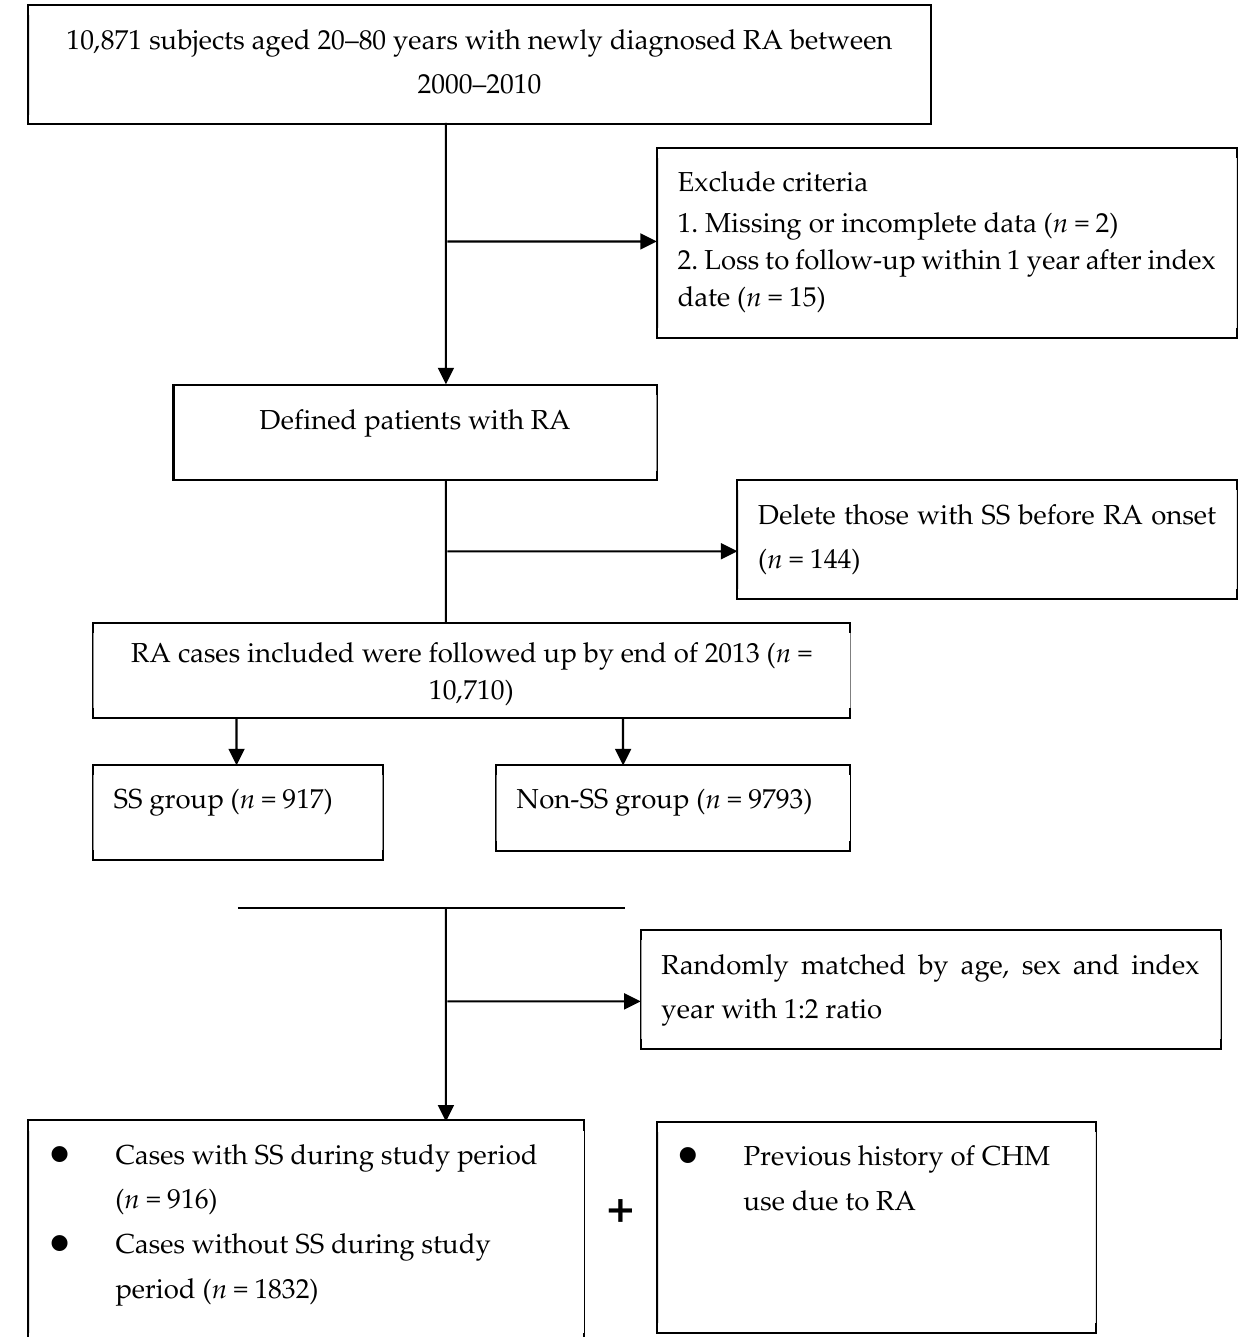
Figure 1. Flowchart of patient screening.